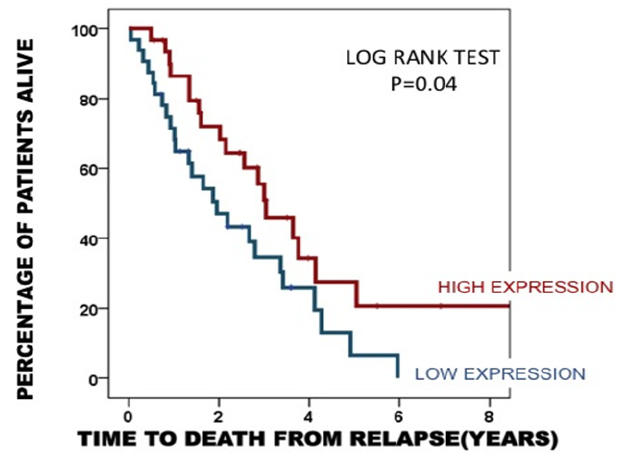
Figure 3. Kaplan Meier plot demonstrates that those patients whose tumours express high pAR 791 in the nucleus (31 patients) have a longer time to death from disease recurrence than those patients whose tumours exhibit low nuclear pAR 791 expression (32 patients). pAR 791 nuclear expression is associated with time to death from disease